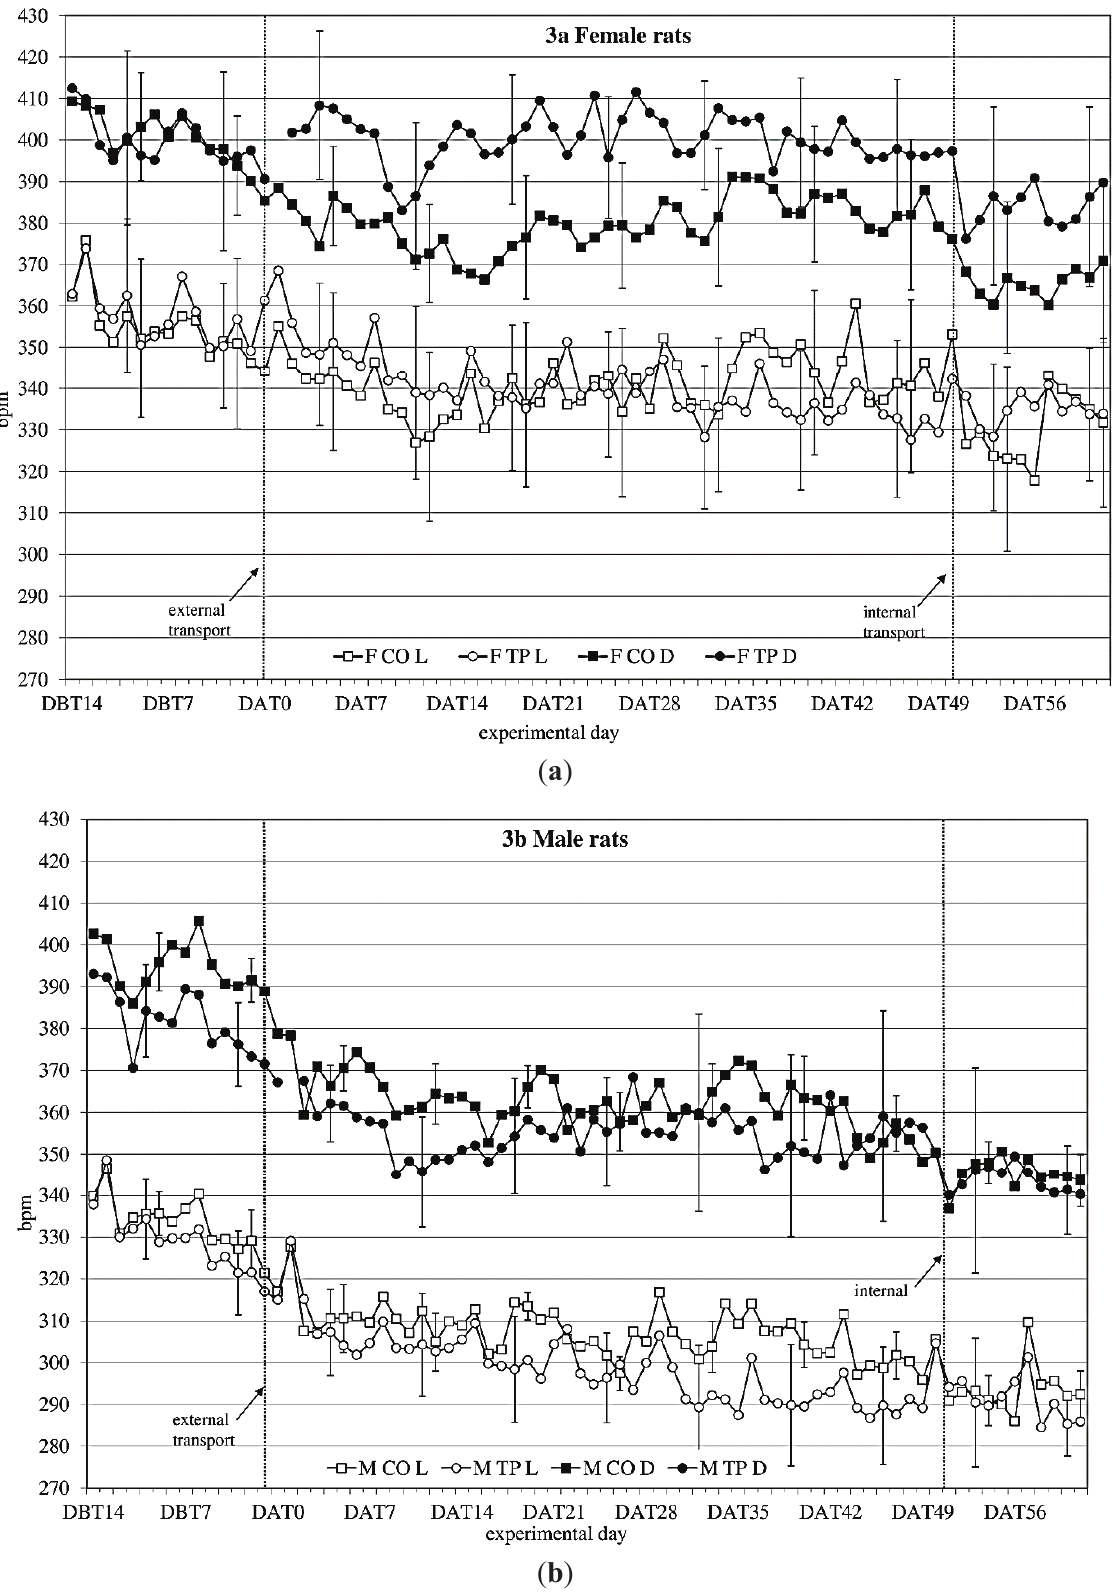
Figure 3. Average 12 h heart rate in beats per minute (bpm) (mean ± weekly standard deviation (SD)) during dark(D) and light(L) period between DBT14 and DAT61 in transported (TP) and control (CO) female ( a ) and male ( b ) WU rats. DBT: day before transfer, DAT: day after transfer (TP: n = 5, CO: n =